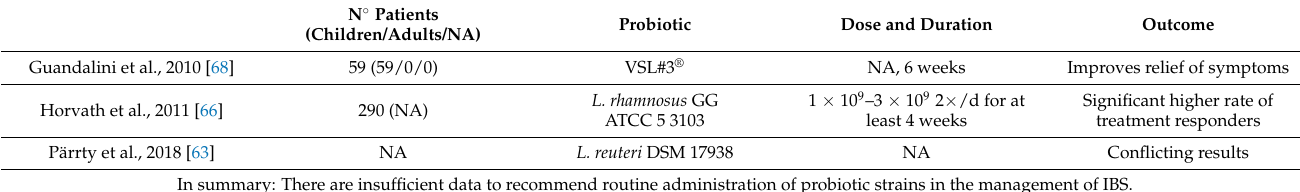
Table 8. Meta-analyses and systematic reviews on probiotics in irritable bowel